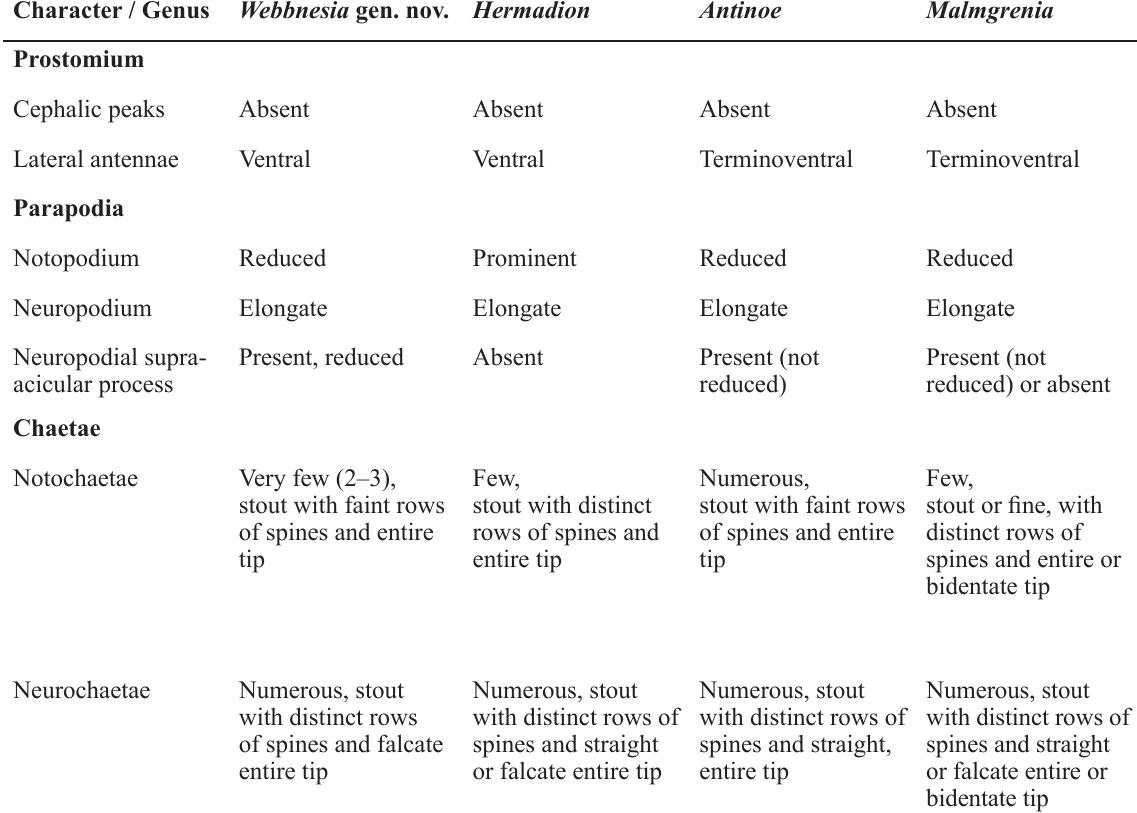
Table 2. Diagnostic generic characters of Webbnesia gen. nov., Hermadion Kinberg, 1856, Antinoe Kinberg, 1856 and Malmgrenia McIntosh,